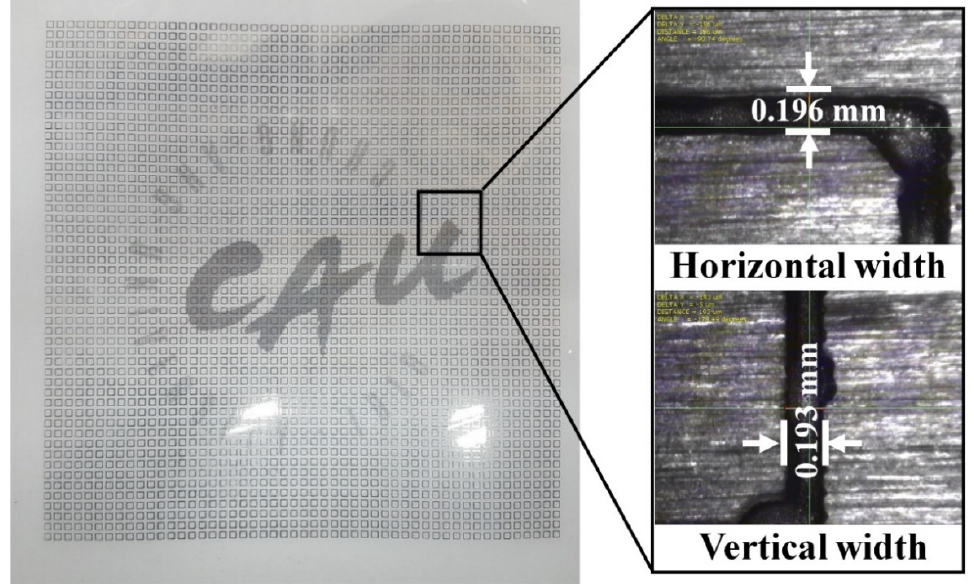
Figure 7. Fabricated prototype and magnified view of the printed surface.